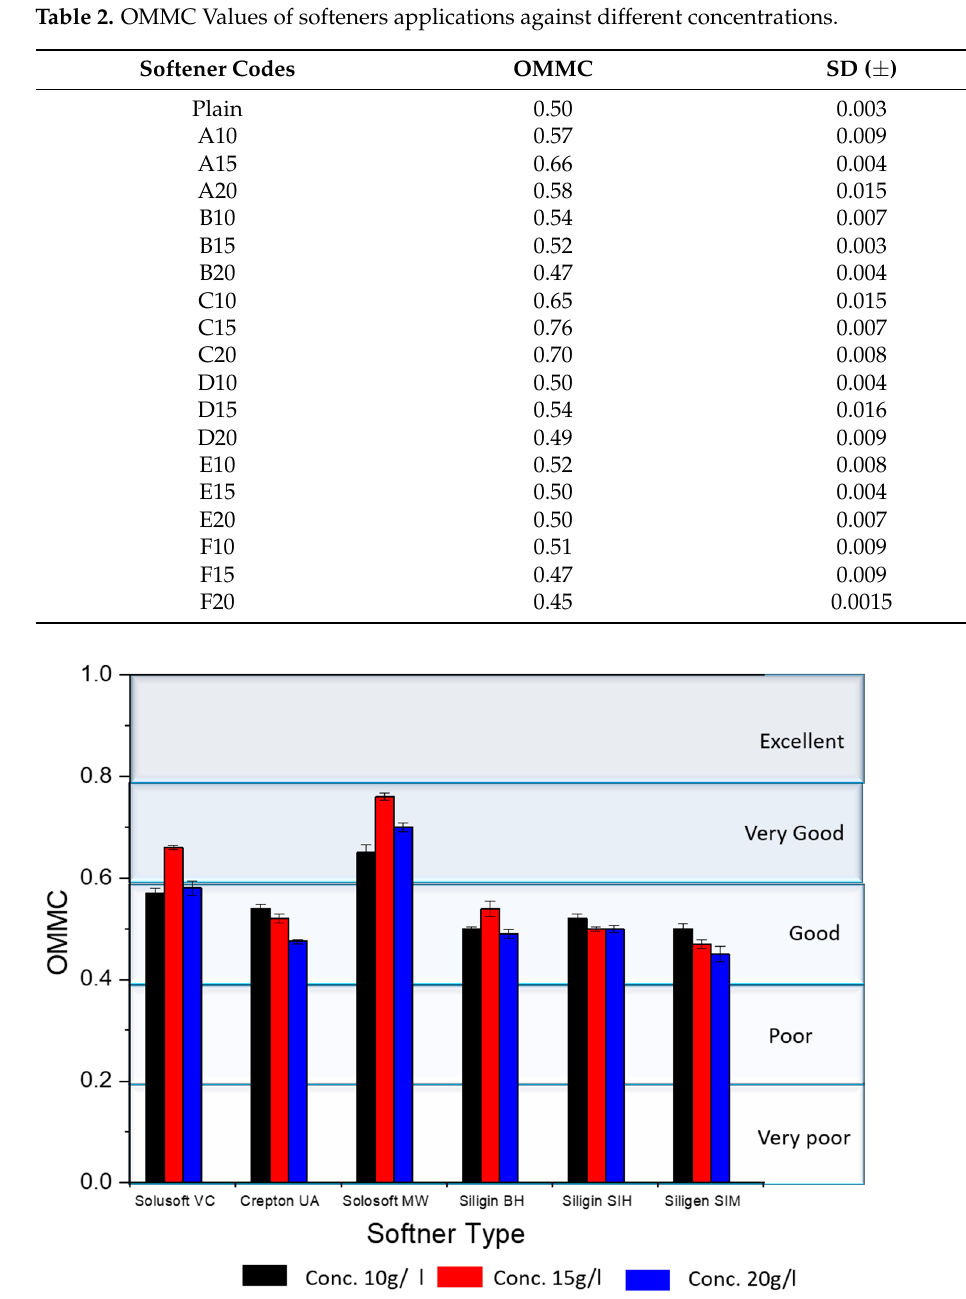
Figure 1. Effect of Softener type and concentration on OMMC of the terry knitted fabric .